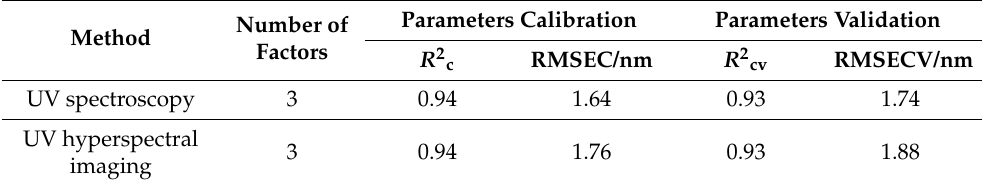
Table 2. Model statistics for the calibration and full cross-validation models for oxide layer thickness on the direct bonded copper. Parameters Number of Method Factors